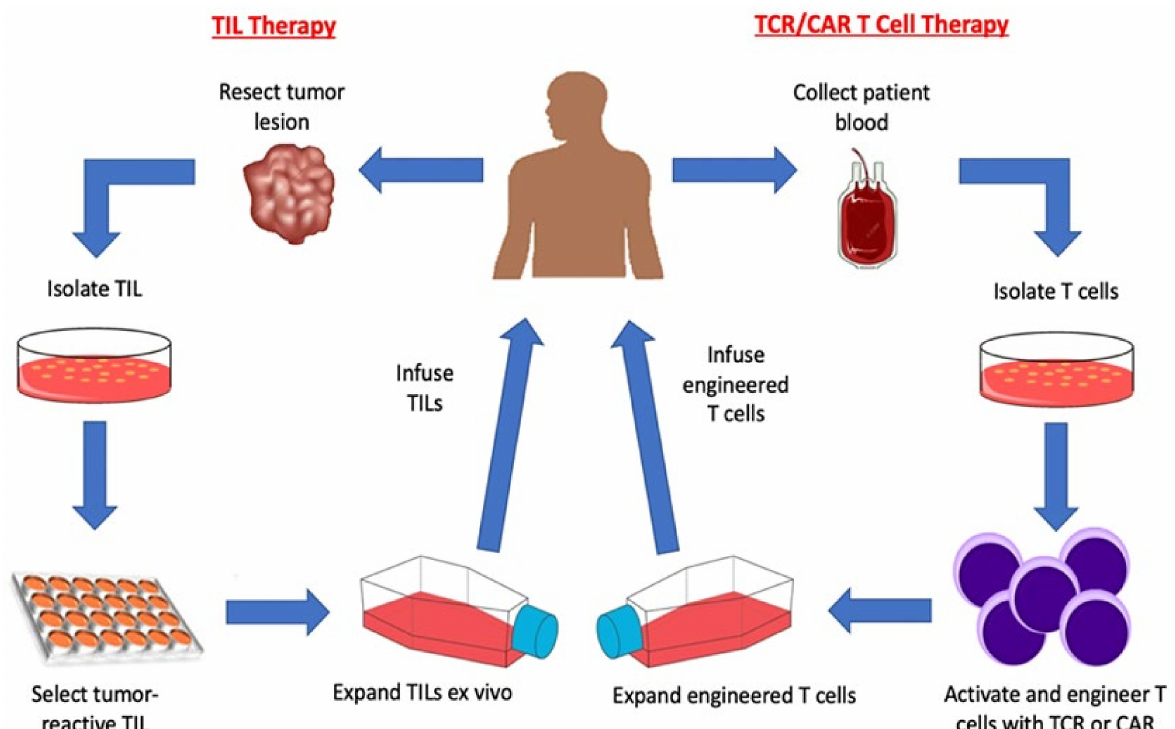
Figure 1. Adoptive T cell therapy strategies. Adoptive T cell therapy for treating cancer patients requires ex vivo expansion of autologous T cells for infusion back into the patient. Adoptive T cell transfer of TIL (left side of the Figure) occurs by first resecting tumor lesions from a patient and then isolating tumor-reactive T cells from that sample. The tumor-reactive T cells are then expanded ex-vivo and infused back into the patient. Adoptive T cell transfer of genetically engineered T cells (right side of the Figure) occurs by first isolating PBL-derived T cells from patient blood then genetically modifying them to express a specific TCR or CAR. The TCR or CAR engineered T cells are then expanded ex-vivo and infused back into the